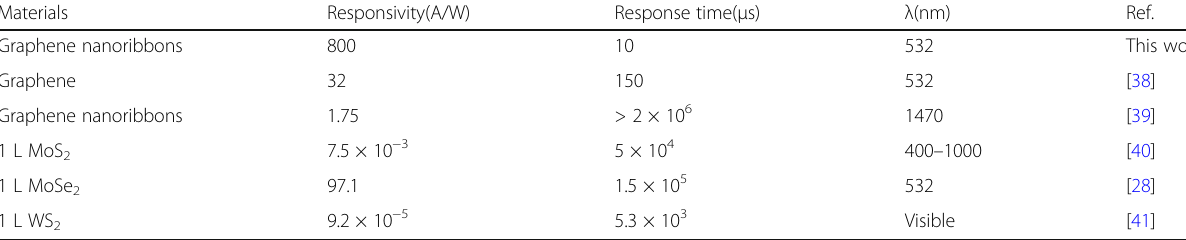
Table 1 Comparison of critical performance indicators in photodetector based on 2D materials Materials